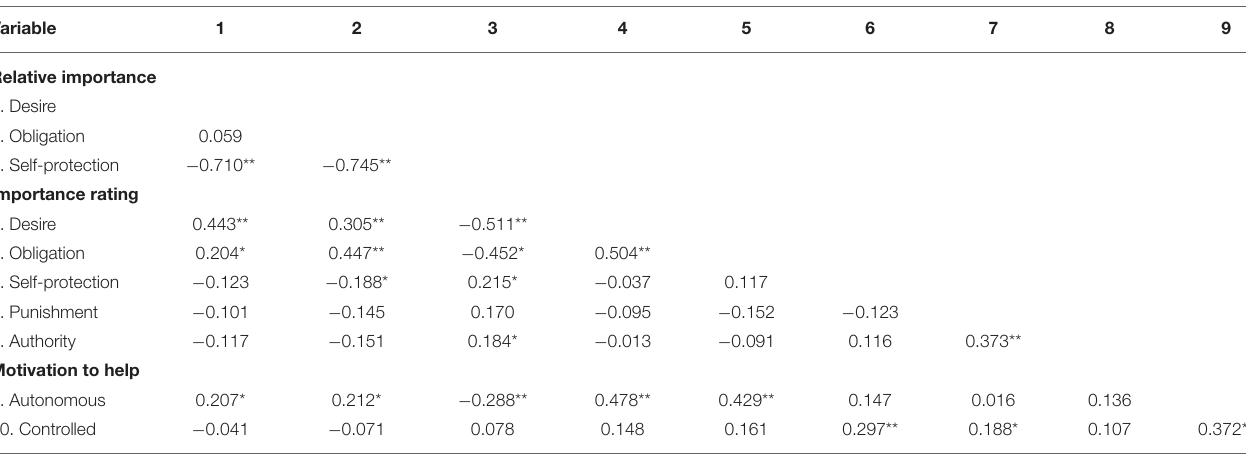
TABLE 2 | Correlations among different motivations in three measures—Chinese participants.